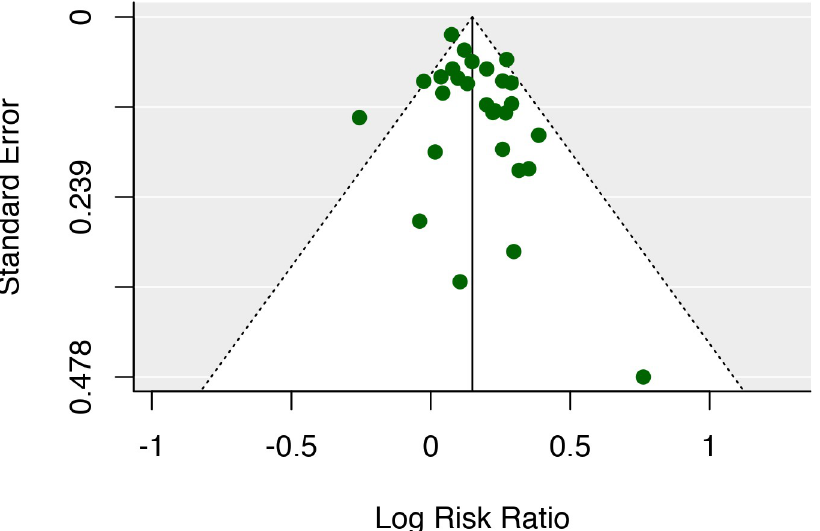
Fig 3. Funnel plot. A Funnel plot did not indicate any outspoken bias in the meta-analysis data.